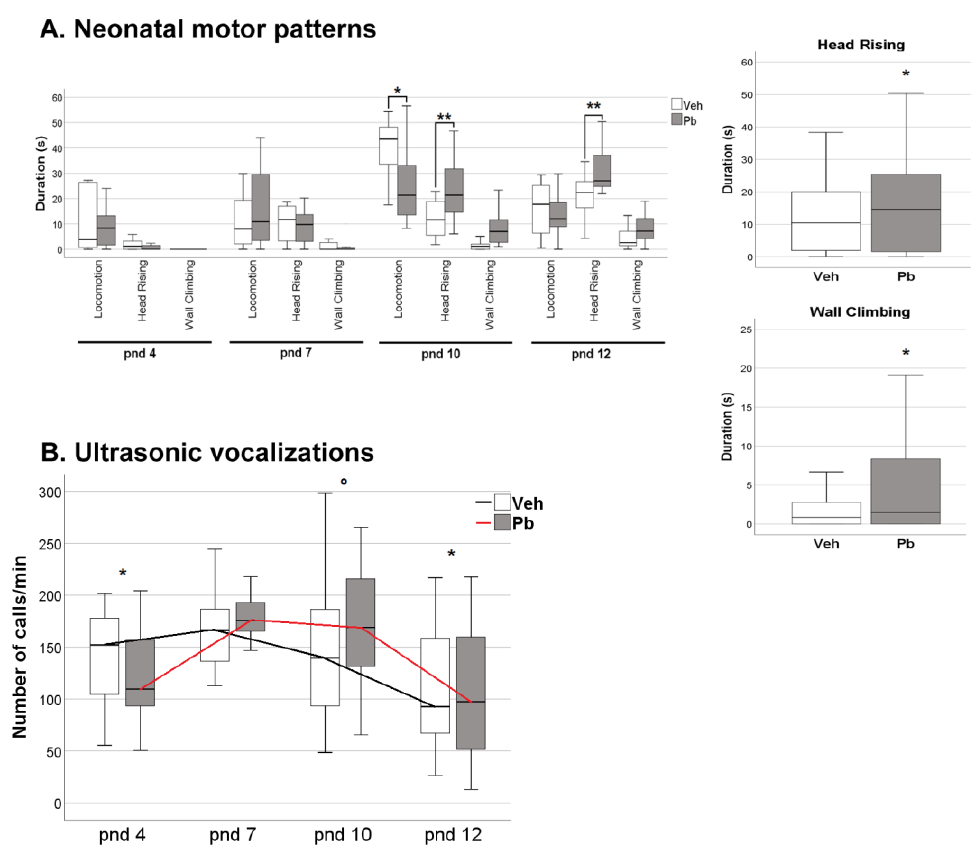
Figure 2. Effects of developmental Pb exposure on neonatal motor patterns and ultrasonic vocalizations (USVs) emitted by pups during a 3 min-test at post-natal day 4, 7, 10, and 12. ( A ) Duration of motor behaviors, namely locomotion, head rising and wall climbing, significantly affected in Pb pups of both sexes, * p < 0.05, ** p < 0.01; ( B ) Temporal profile of USV emission, * p < 0.05 vs. post-natal day 7, ° p < 0.05 vs. post-natal day 12. Data are sex-pooled represented; n = 12 (6 females and 6 males)/group.